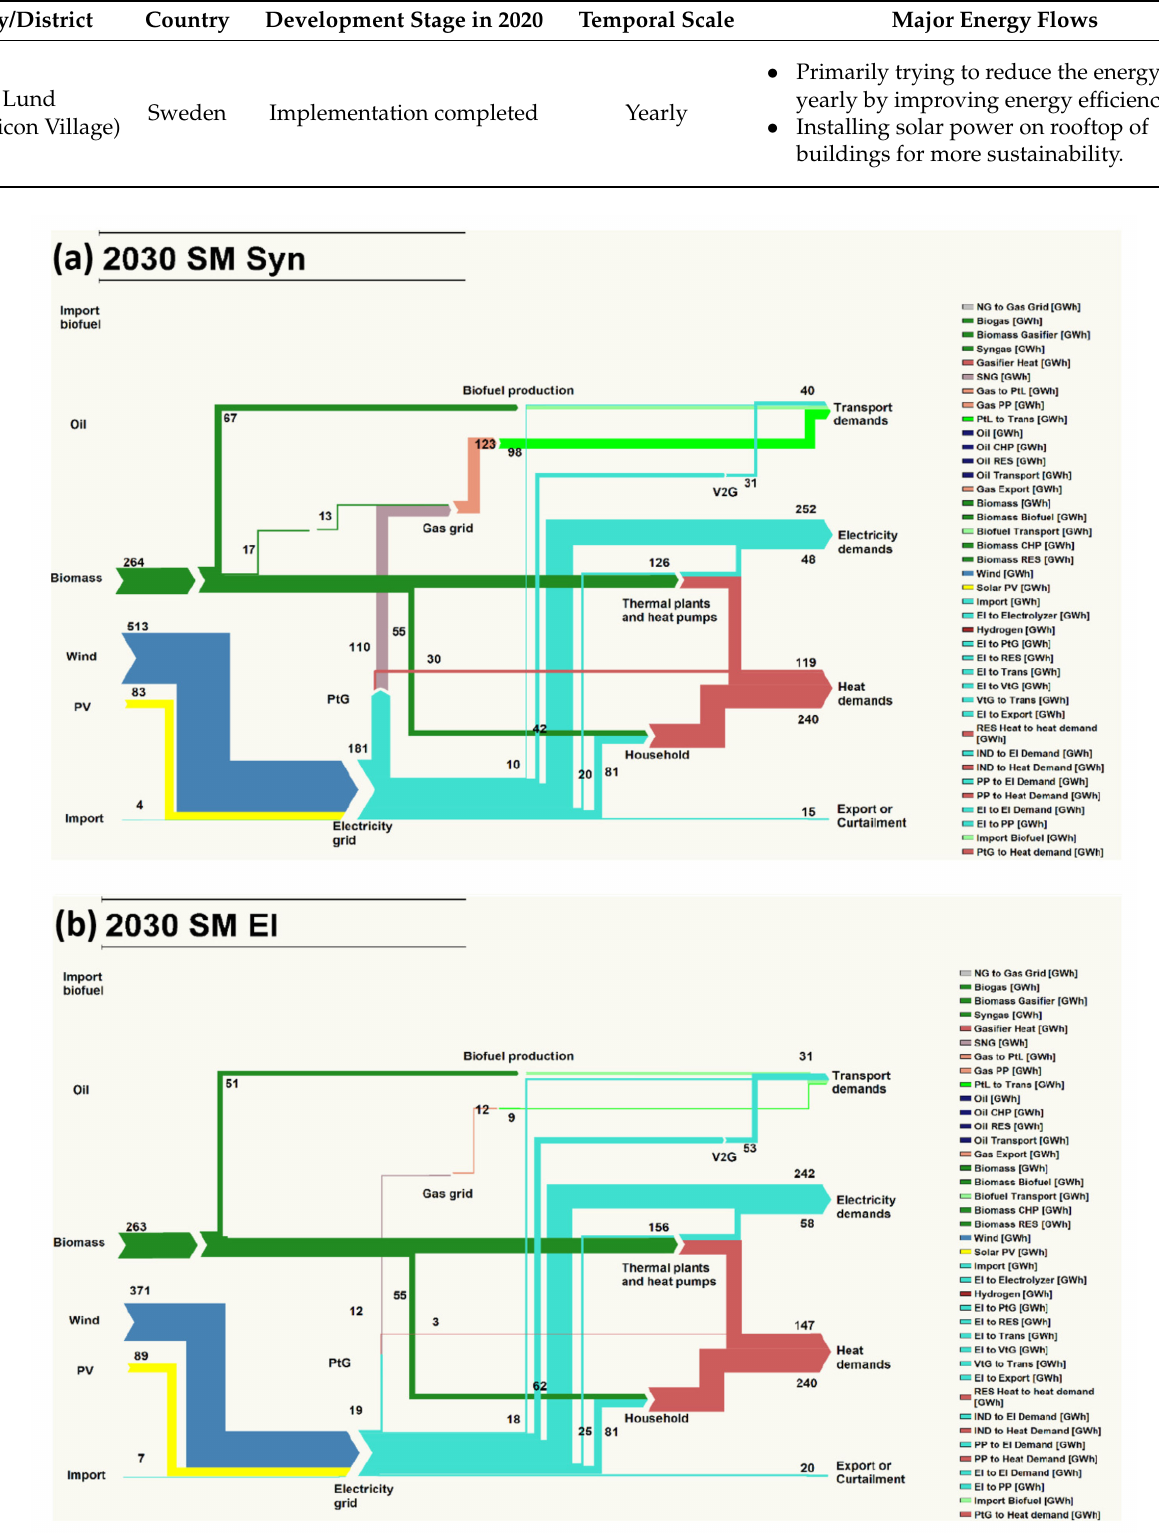
Figure 12. The annual energy flows in the year 2030 at Åland Island towards 2030 target—100% sustainable mobility for two scenarios: ( a ) SM Syn scenario—domestic production of sustainable fuels and ( b ) SM EI scenario—high electrification. Reprinted from